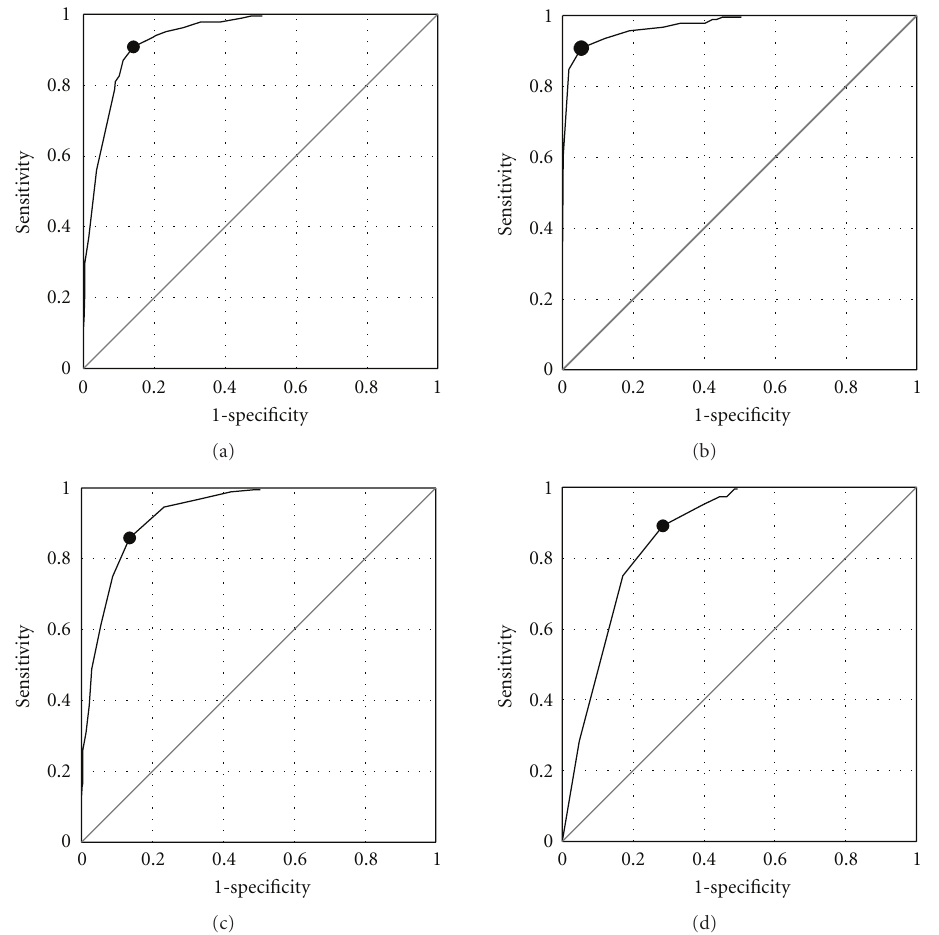
Figure 2: E ffi ciency of filtering steps and paired HMM. Receiver operating characteristic (ROC) curves for filters on (a) minimum length of stem-loop region, (b) fraction of base pairs in a sliding window of 25 states, (c) number of consecutive base pairs, and (d) ratio of sequence and stem-loop length. The area under the curve (AUC) is (a) 0.94, (b) 0.97, (c) 0.93, and (d) 0.87. The dots (at max(sensitivity + specificity − 1)) denote the value pair of sensitivity and false positive rate that optimally discriminates between miRNA and non-miRNA sequences. The data set consisted of all plant miRNA sequences from miRBase 10 and 455 non-miRNA sequences from Rfam